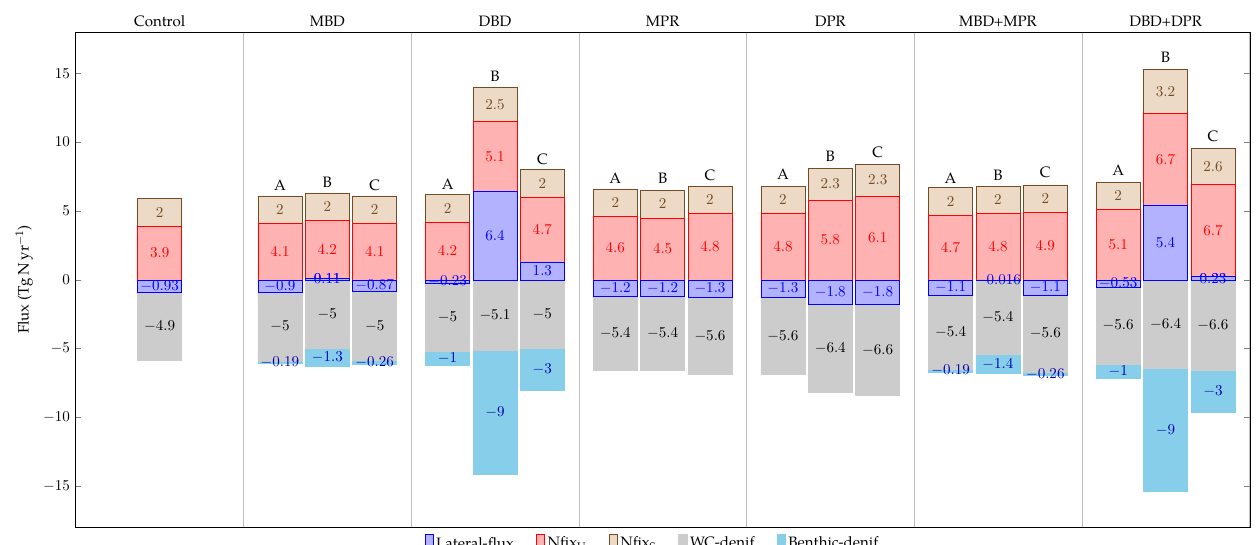
Figure 4. Nitrogen fluxes after including benthic denitrification and/or phosphorus regeneration. Lateral-flux is the nitrogen efflux or influx through the southern boundary; Nfix U and Nfix S represent the nitrogen fixation rate by NF in the U and S boxes, respectively; WC-denif is water-column denitrification; Benthic-denif represents the fixed-N loss via benthic denitrification in the model domain. Bar labels: A, main experiments; B, sensitivity experiments with high-BD; C, sensitivity experiments with Martin curve exponent b = 0 .